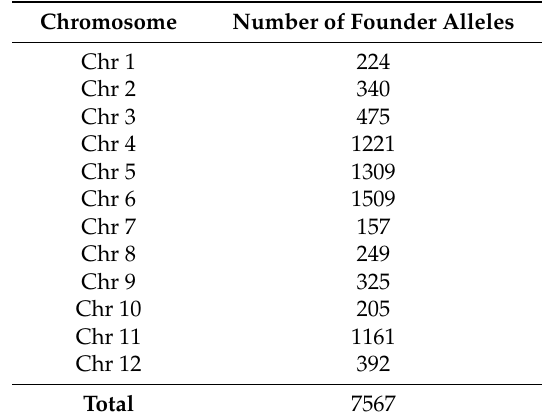
Table 3. Chromosome-wide distribution of polymorphic founder